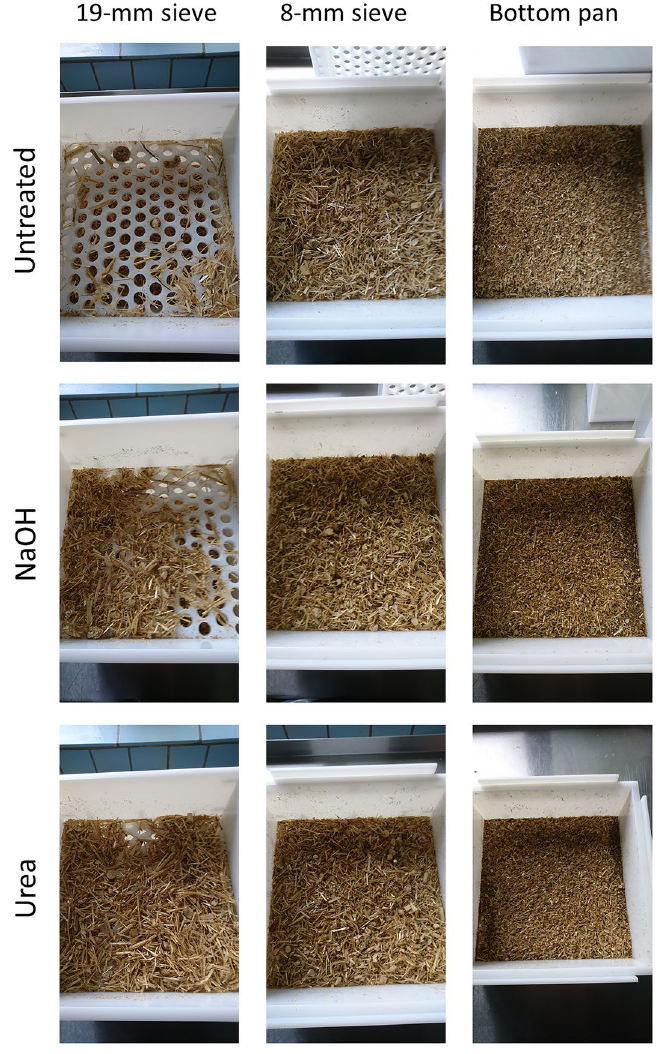
Figure 1. Illustration of particle size distribution of as fed “wet” TMR composed of 33.5% maize silage, 21.6% rapeseed meal, 26.7% barley grains, and 18.2% of untreated, NaOH treated, or urea treated barley straw on dry matter basis using the method described by Lammers et al. 22 and Heinrichs and Jones 23 . TMR, total mixed